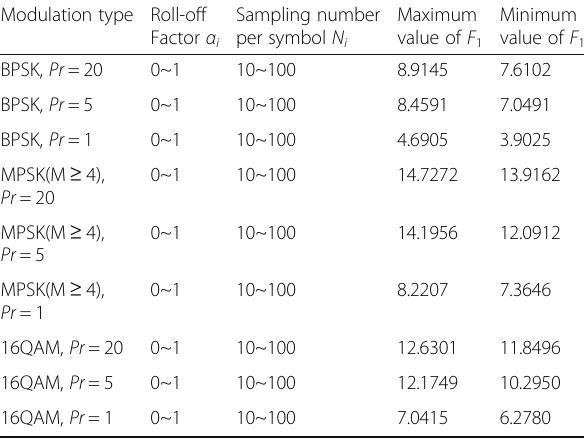
Table 1 The HOS feature F 1 under different α i and N i